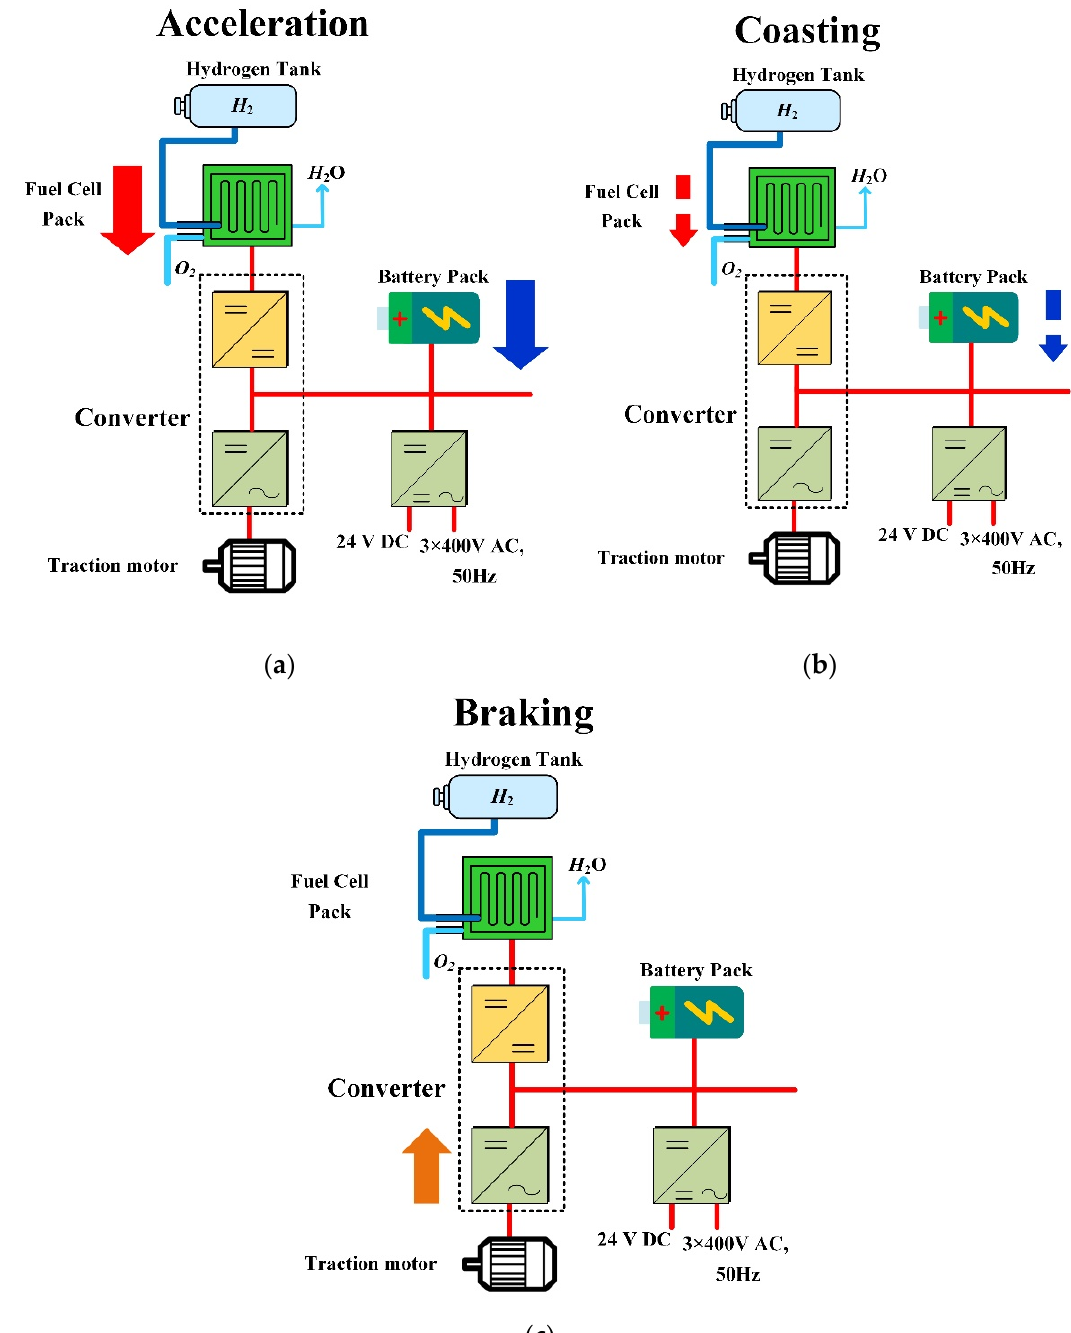
Figure 11. Operation modes of the Coradia iLint: ( a ) acceleration, ( b ) coasting, ( c ) braking.